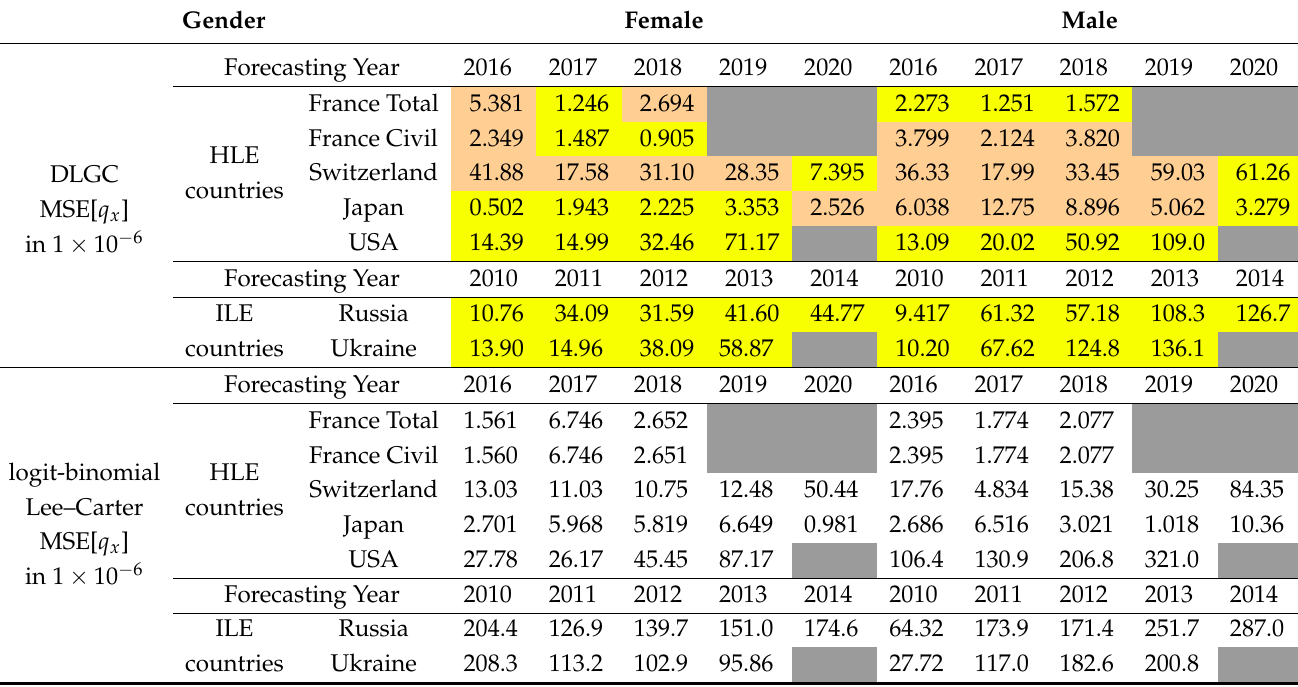
Table 3. Comparing 5-year-ahead forecasts’ MSE[ q x ] of the logit-binomial Lee–Carter model and DLGC. Gender Female Male Forecasting Year